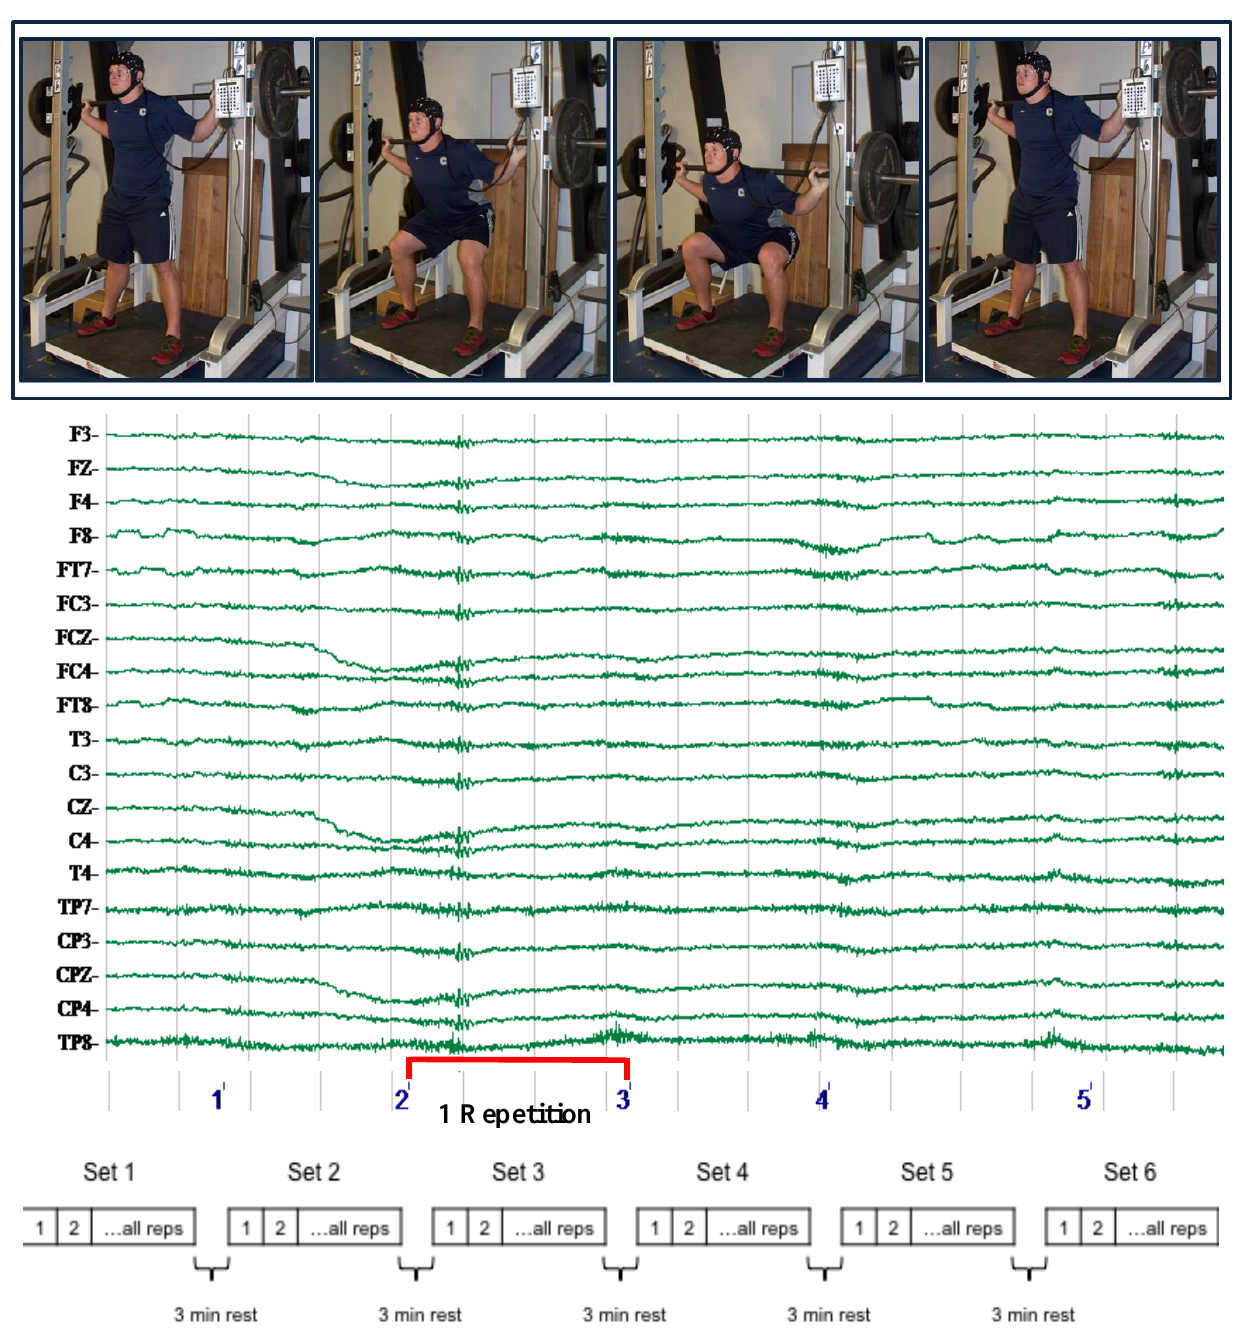
Figure 4. Experimental Movement and Design Process. Subjects completed 6 repetitions of the squat movement at the prescribed load for each set. All protocols included 6 sets with three minutes of rest